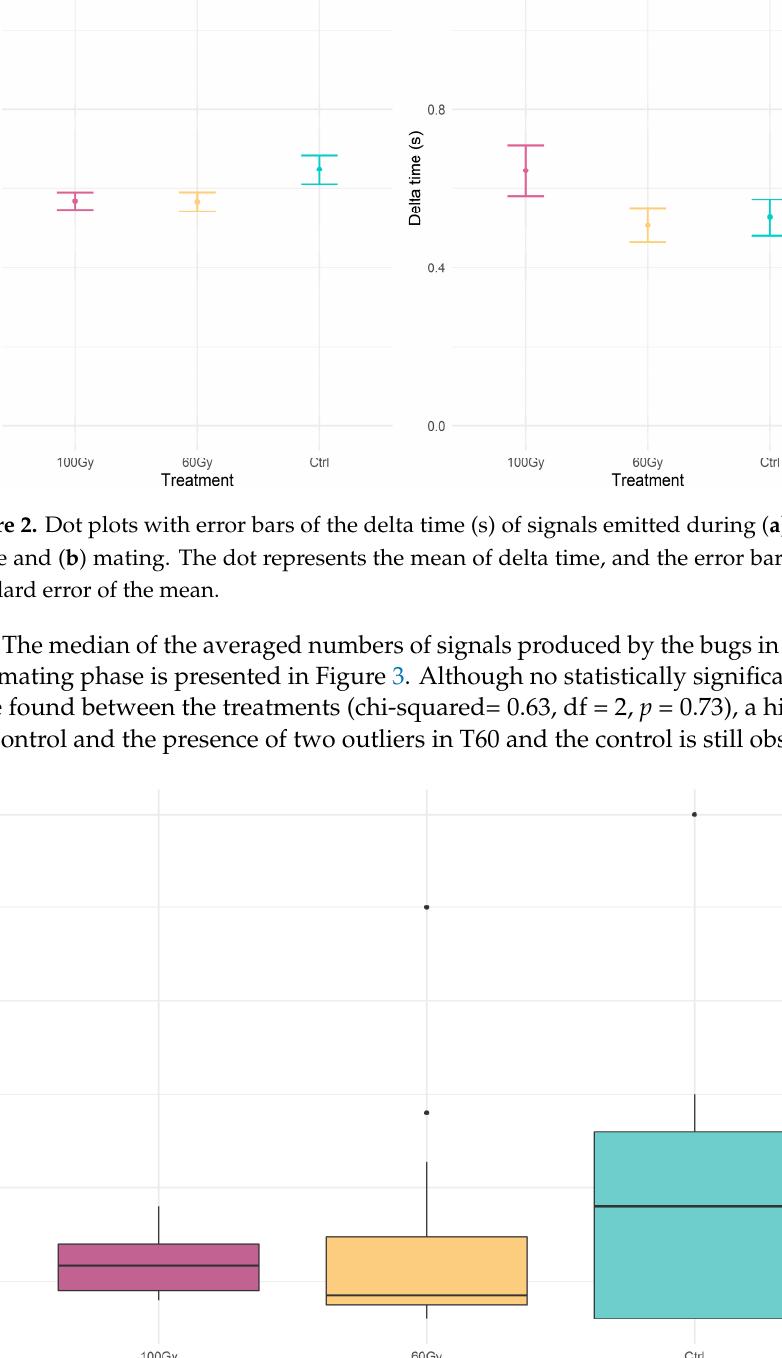
Figure 1. Dot plots with error bars of the peak frequency (Hz) of signals emi tt ed during ( a ) the mount phase and ( b ) the mating. The dot represents the mean of peak frequency, and the error bar represents the standard error of the mean. The treatments indicated with di ff erent le tt ers show signi fi cant di ff erences (Kruskal–Wallis test at p < 0.001).